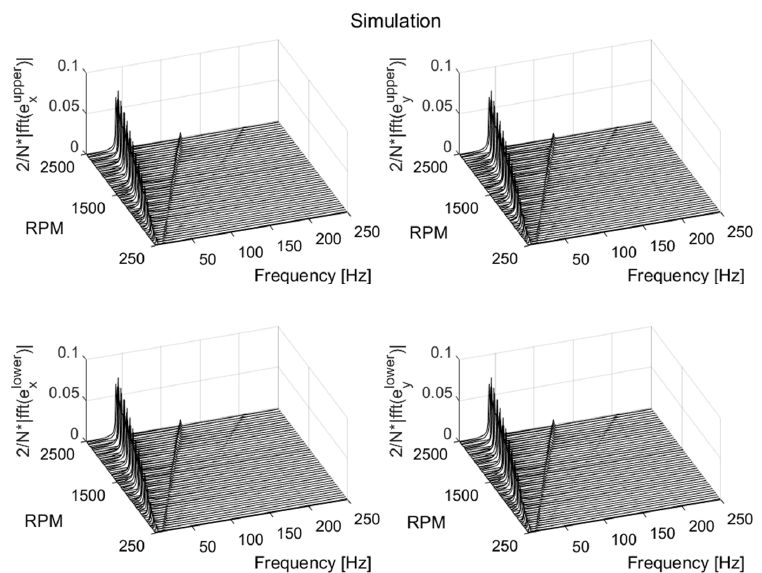
Figure 23. The waterfall diagram of the simulated shaft displacement with 5.9 × 10 − 3 kg·m and 2 π rad/s 2 . N is the number of samples.